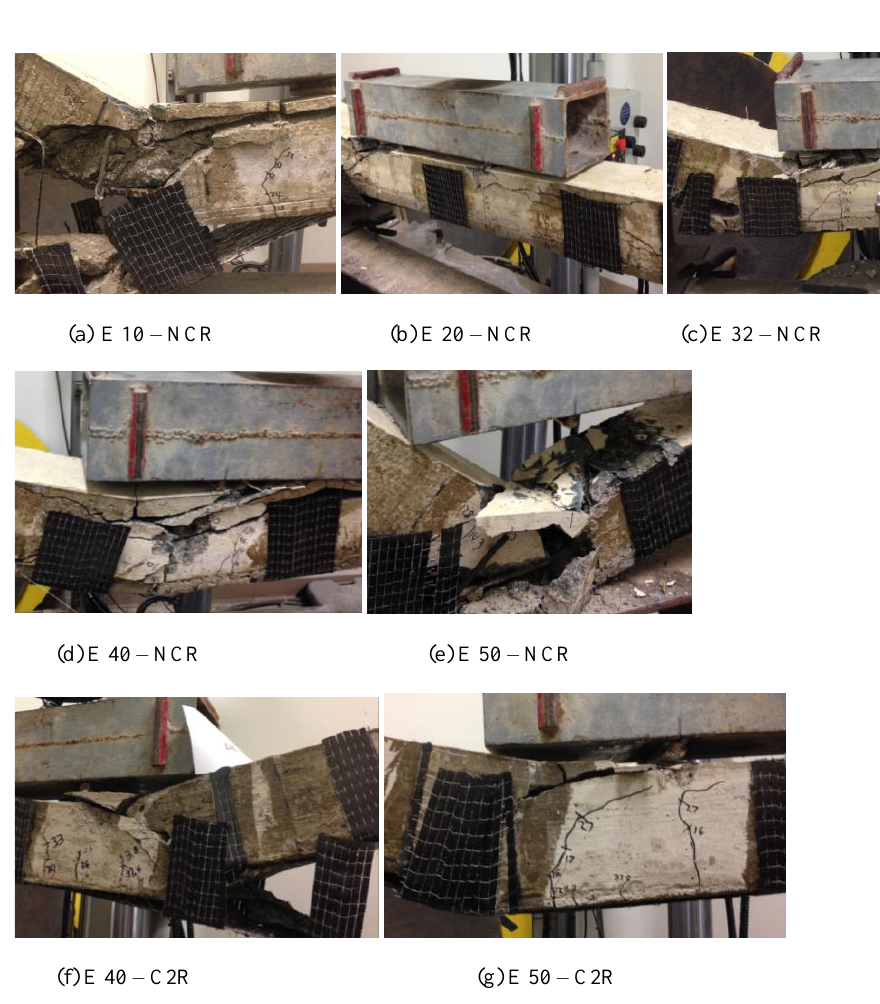
Figure 22. Failure of beams without cover and repaired with double sheets.